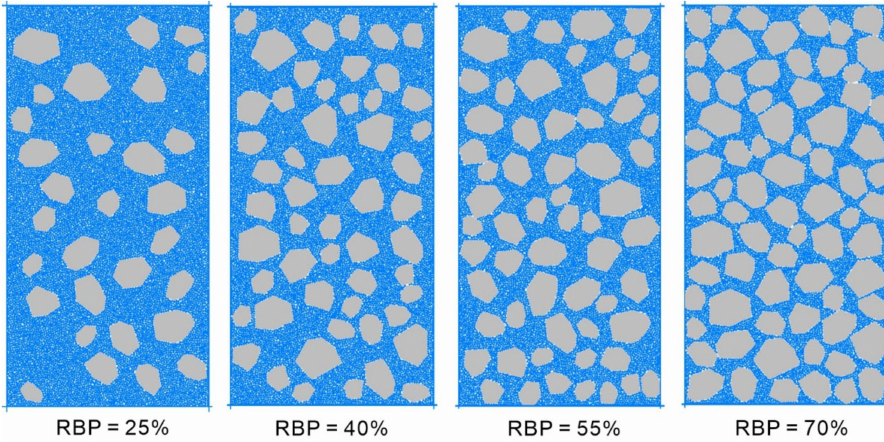
Figure 4. Numerical specimens of the